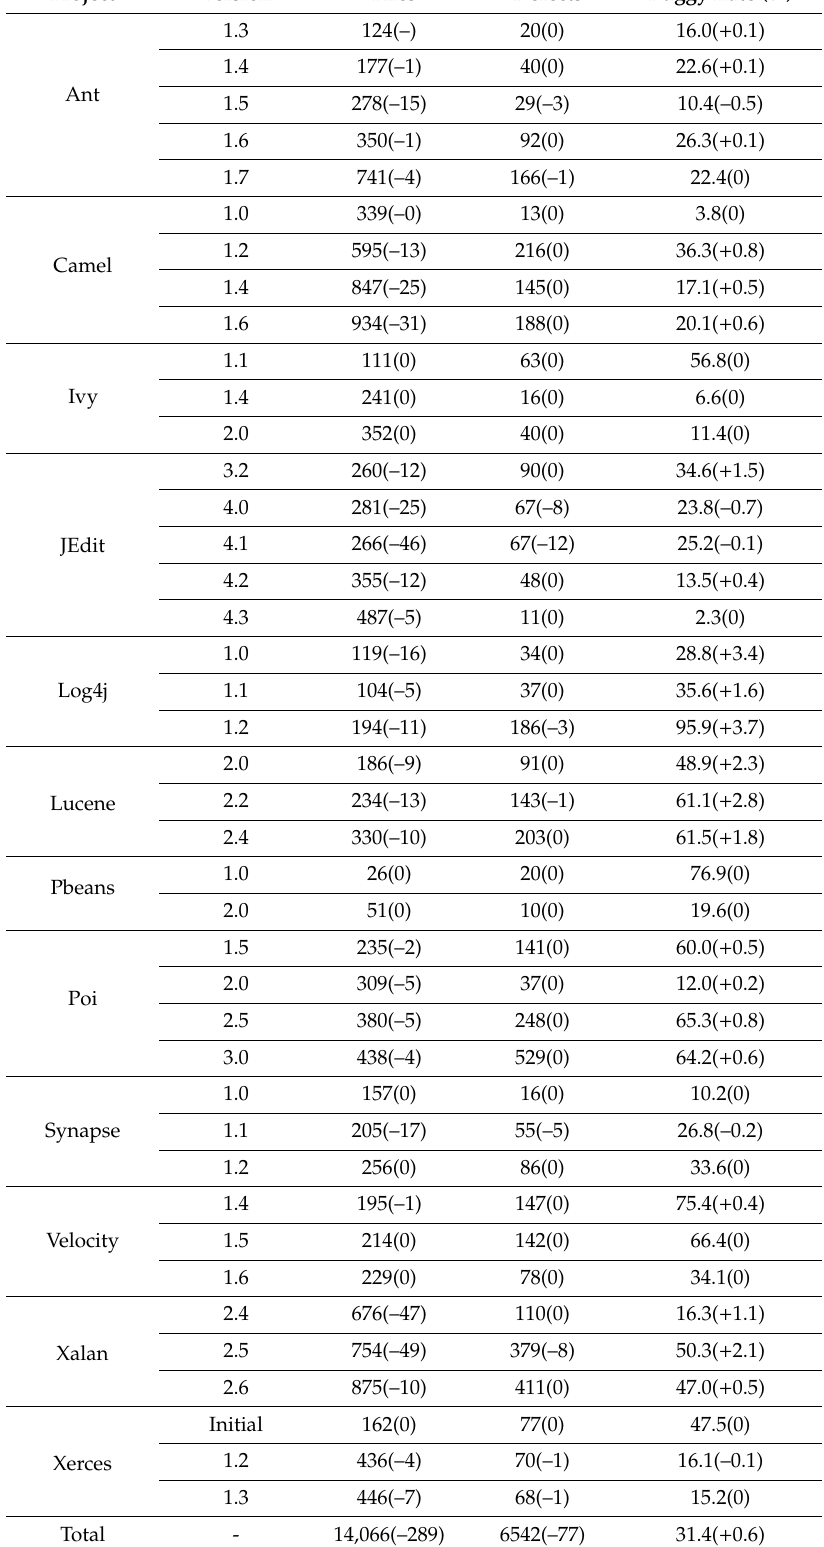
Table 3. PROMISE Source Code (PSC) dataset description. PSC is applied for within-version WPDP. Numbers in brackets indicate numeral changes compared with the original dataset from PROMISE